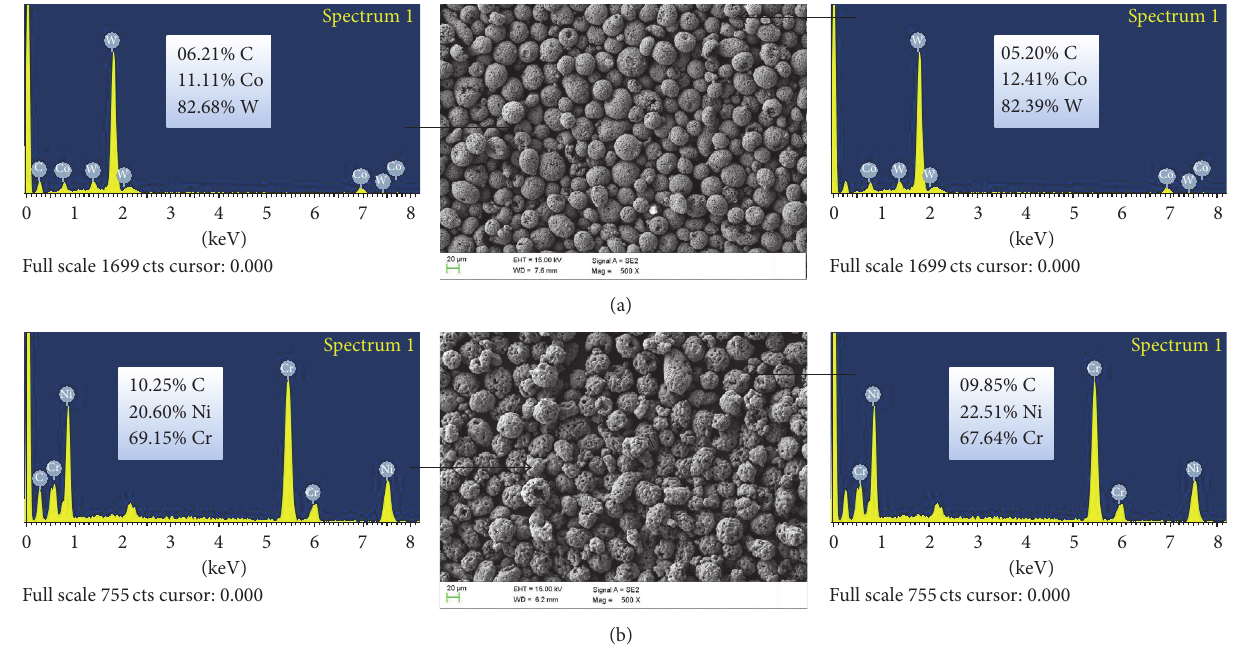
Figure 1: SEM images and EDS patterns showing the morphologies, microstructure, and elemental composition of the (a) WC-12% Co; (b) Cr 3 C 2 -25% NiCr feedstock powders.